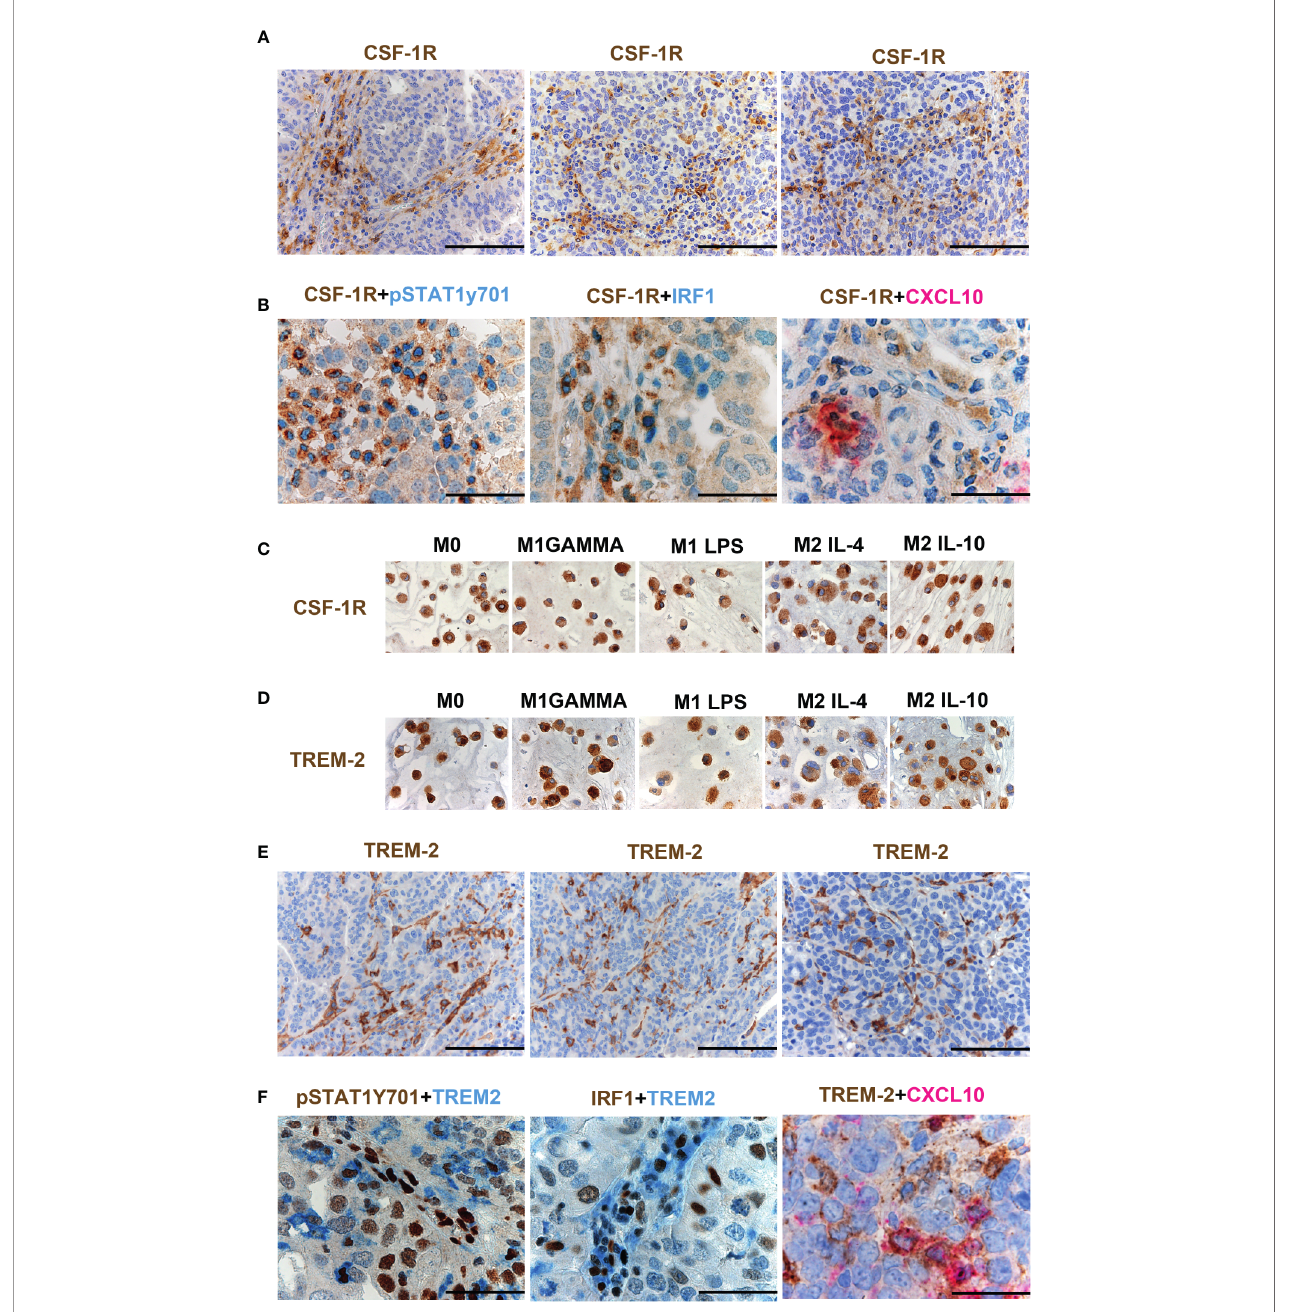
FIGURE 6 | CSF1R and TREM-2 expression in OCs. Sections from HGSCs cases (A, B, E, F) and from cell-block preparations of polarized monocyte-derived M f (C, D) immunostained as labeled. Magni fi cation 200× ( A , E ; scale bar 100 um) and 400× ( B , F , scale bar 50 um). CSF1R expression in OCs is largely restricted to TAMs (A) . Double immunohistochemistry showing co-expression of pSTAT1Y701, IRF1 and CXCL10 in CSF1R + TAMs (B) . M1 type and M2 type M f generated from peripheral blood monocytes express CSF1R (C) . M1 type M f generated from peripheral blood monocytes express TREM2 (D) . TREM2 is expressed on TAMs in HGSCS. TREM2 + TAMs detected in Hi OC-IS 30 CD163 Hi (E) ; a fraction of TREM2 + TAMs co-expressed pSTAT1Y701, IRF1 and CXCL10 (F)